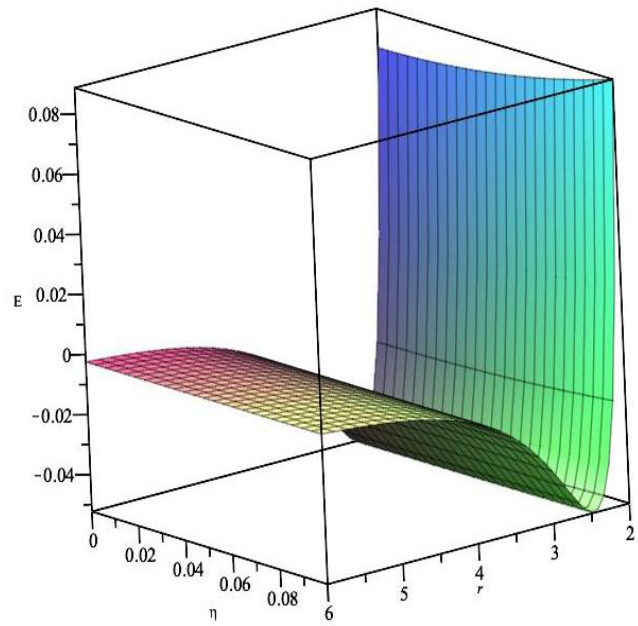
Figure 4. Total energy for a Li atom stored inside a C N